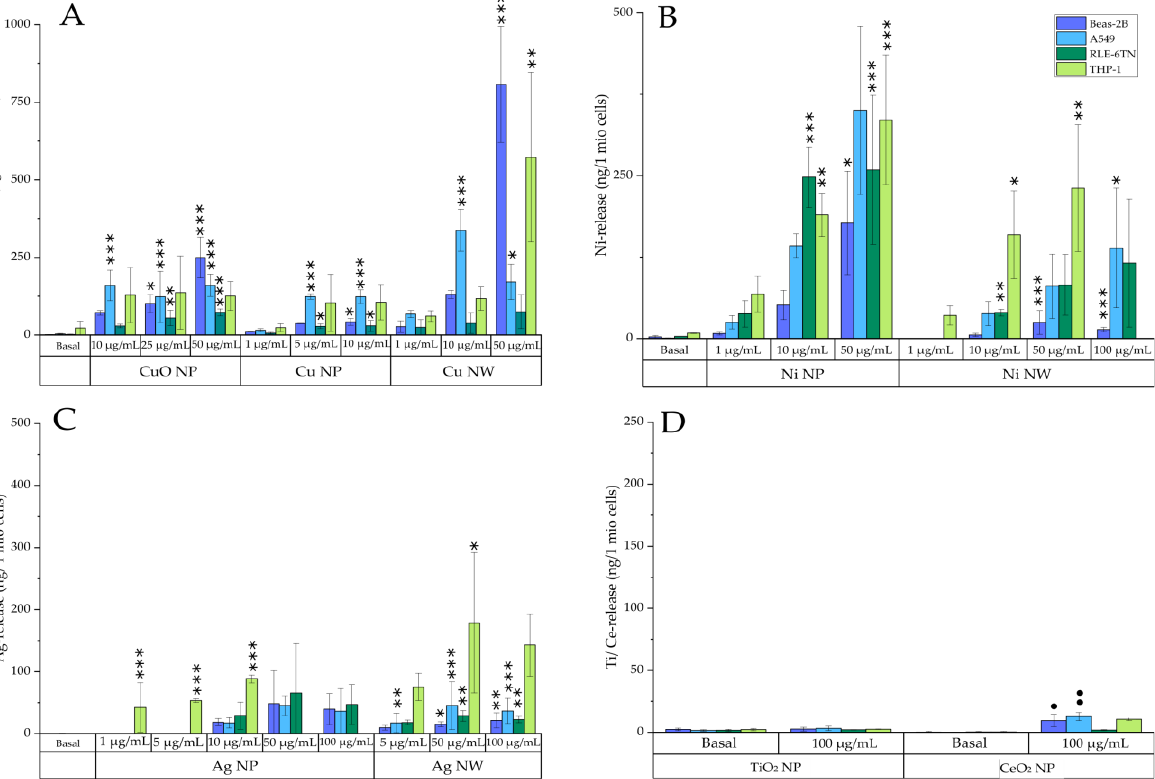
Figure 4. Bioavailability of Cu- ( A ), Ni- ( B ), Ag- ( C ), and Ce- and Ti-based materials ( D ) in A549 (light blue), Beas-2B (purple), RLE-6TN (dark green), and dTHP-1 (light green) cells. Bioavailability is displayed as ion release in ng/10 6 cells. Cells were incubated with nanomaterials for 24 h in their corresponding cell culture media. Depicted are the means of three independently performed experiments ± standard deviation. Statistics were performed using either ANOVA-Dunnett’s test (* p ≤ 0.05, ** p ≤ 0.01, *** p ≤ 0.001) or the unpaired t test (• p ≤ 0.05, •• p ≤ 0.01 ) to compare differences from basal concentration.